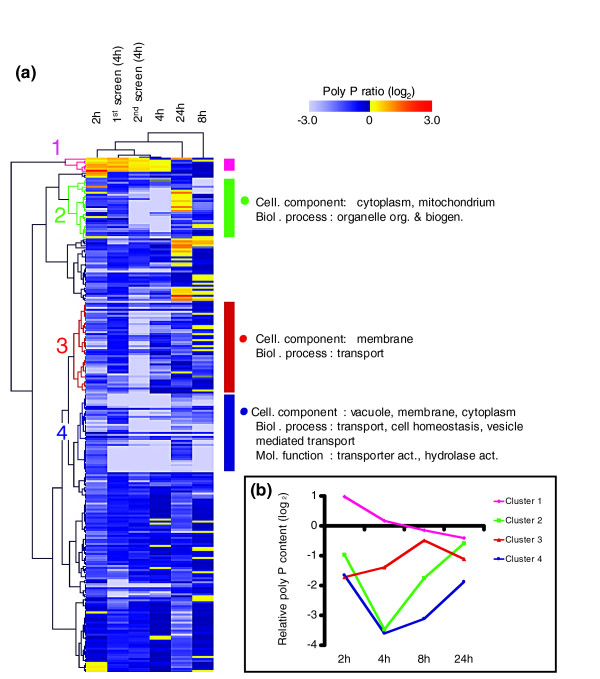
Clustering of all 255 genes found in this poly P screen resolved distinct groups with similar poly P profiles. (a) Hierarchical clustering (uncentered Pearson correlation, complete linkage) of all log2-transformed data (relative to the wild-type). Clusters significantly enriched (P ≤ 0.05) for any GO Slim category are marked by colored bars and branches. (b) Average poly P values (log2-transformed, relative to the wild type) for all genes in the four distinct clusters in (a) at the four time-points.